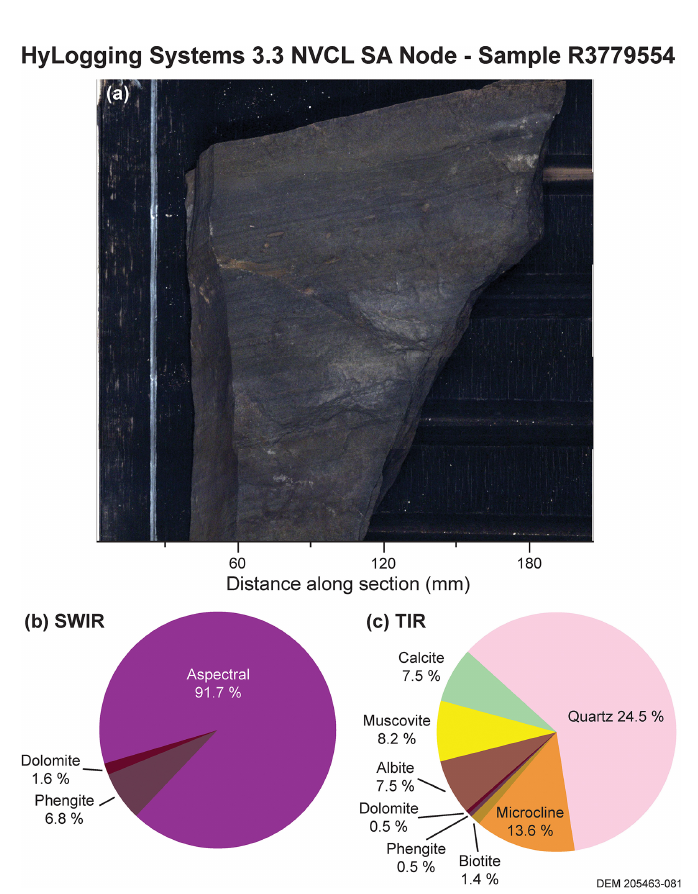
Figure A5. Hyperspectral mineralogy results for sample